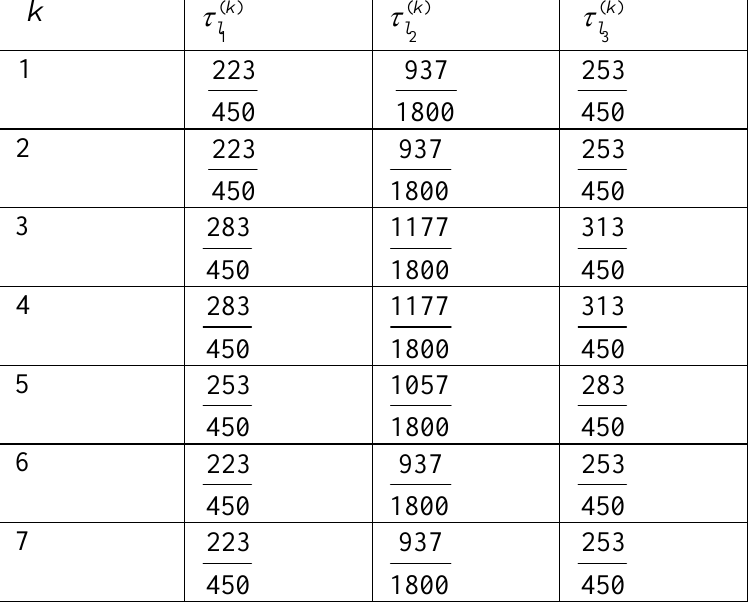
Table 2. The optimal link toll function coefficients and optimal tolls (standard Stackelberg